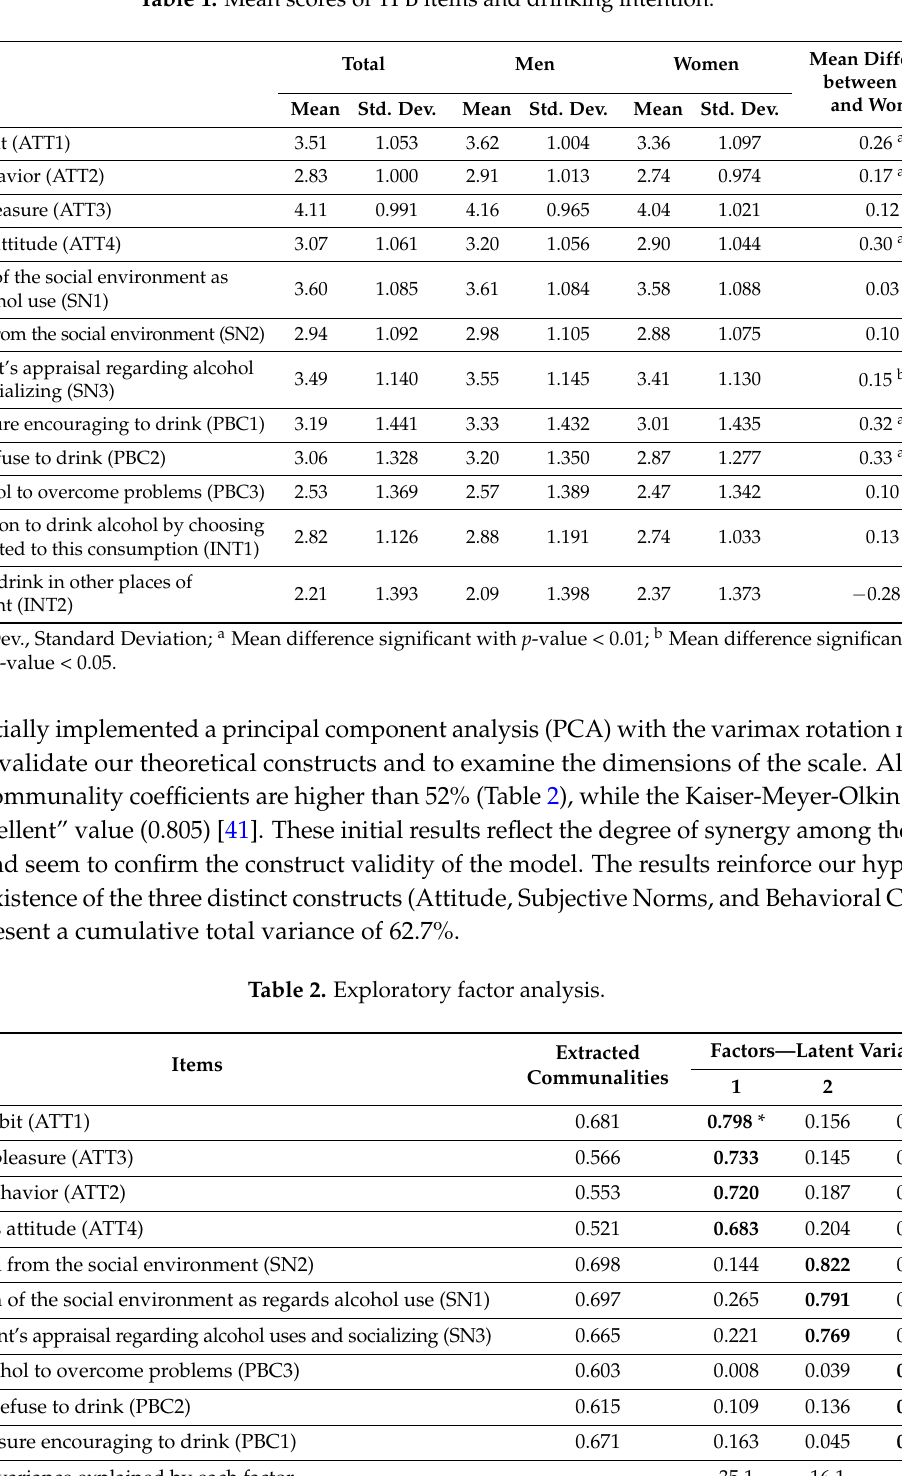
Table 1. Mean scores of TPB items and drinking intention.